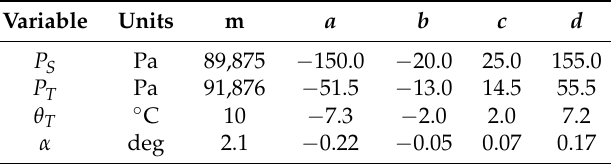
Table 5. Sensor Fault Sets.